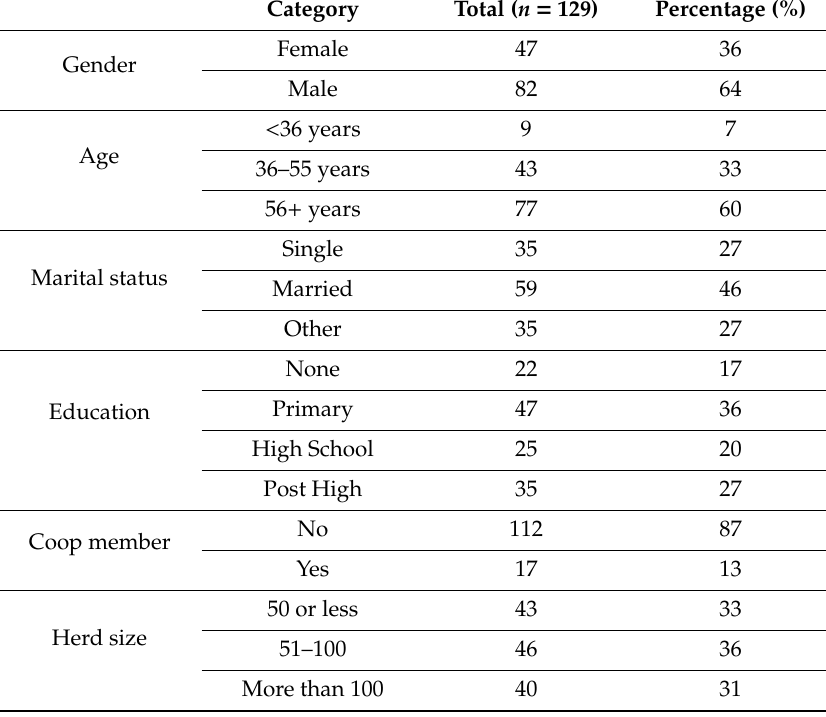
Table 3. Demographic characteristics of survey